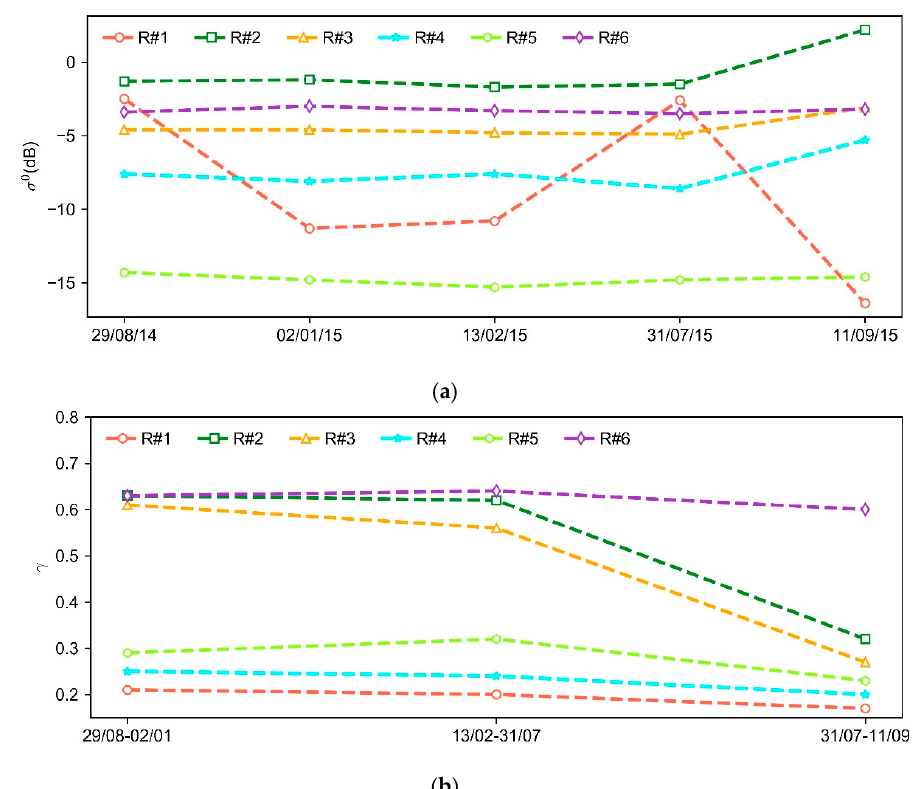
Figure 7. ALOS-2/PALSAR-2 σ ° and γ temporal variation for several typical landscapes within the Figure 7. ALOS-2 / PALSAR-2 σ ◦ and γ temporal variation for several typical landscapes within the Joso study area: ( a ) σ ° temporal trends; ( b ) γ temporal trends. Joso study area: ( a ) σ ◦ temporal trends; ( b ) γ temporal